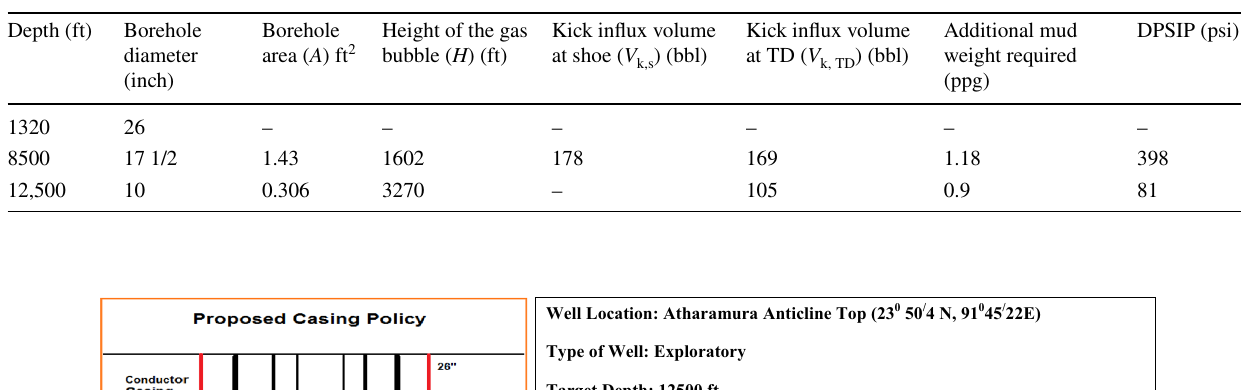
Table 6 Calculated kick tolerance parameters